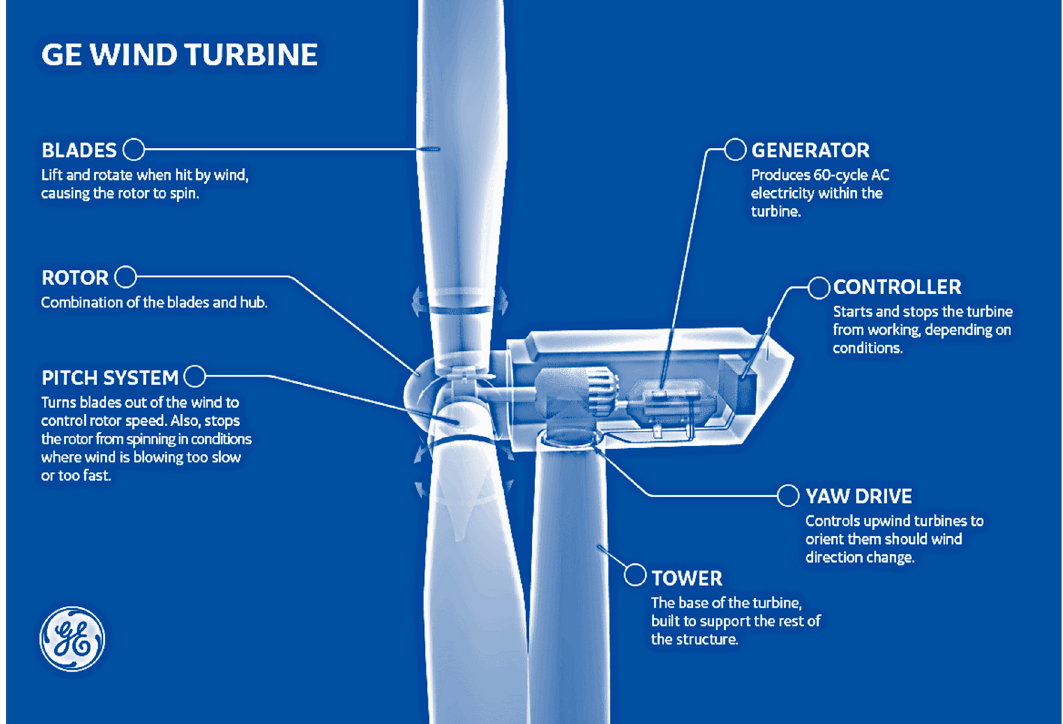
Figure 19. Typical variable-speed direct-driven PMSG wind turbine. Source: GE [153]